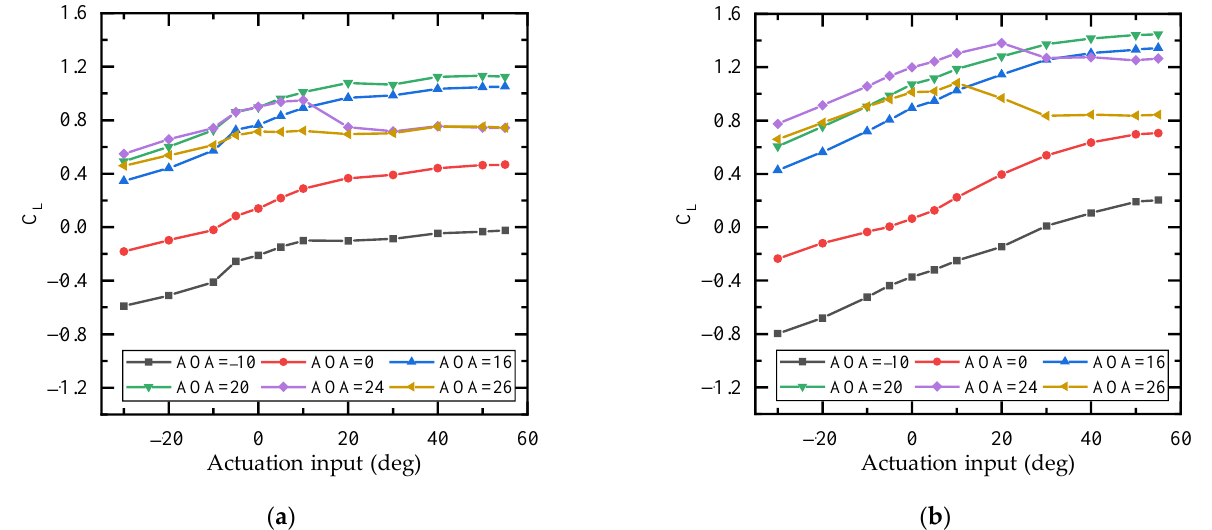
Figure 23. Lift coefficient versus actuation input for mTE4 at different airspeeds. ( a ) Airspeed 10 m/s. ( b ) Airspeed 25 m/s.